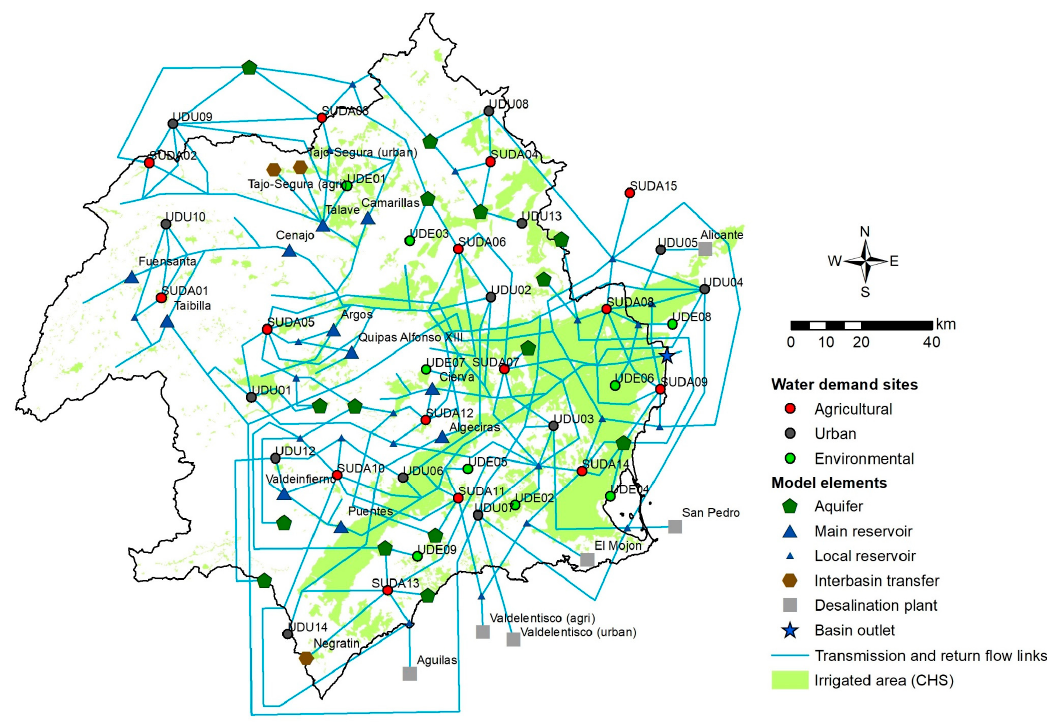
Figure 2. Schematization of the WEAP Segura model.